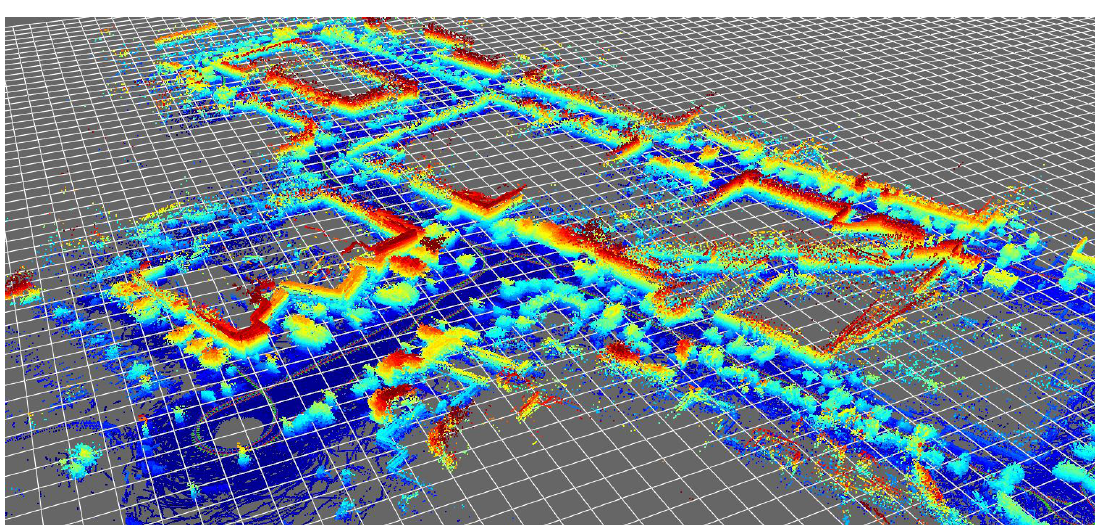
Figure 1. Overview of the ground-truth 3D map used in the benchmarks, representing ∼ 100,000 m 2 of the campus of the University of Almeria, points colorized by